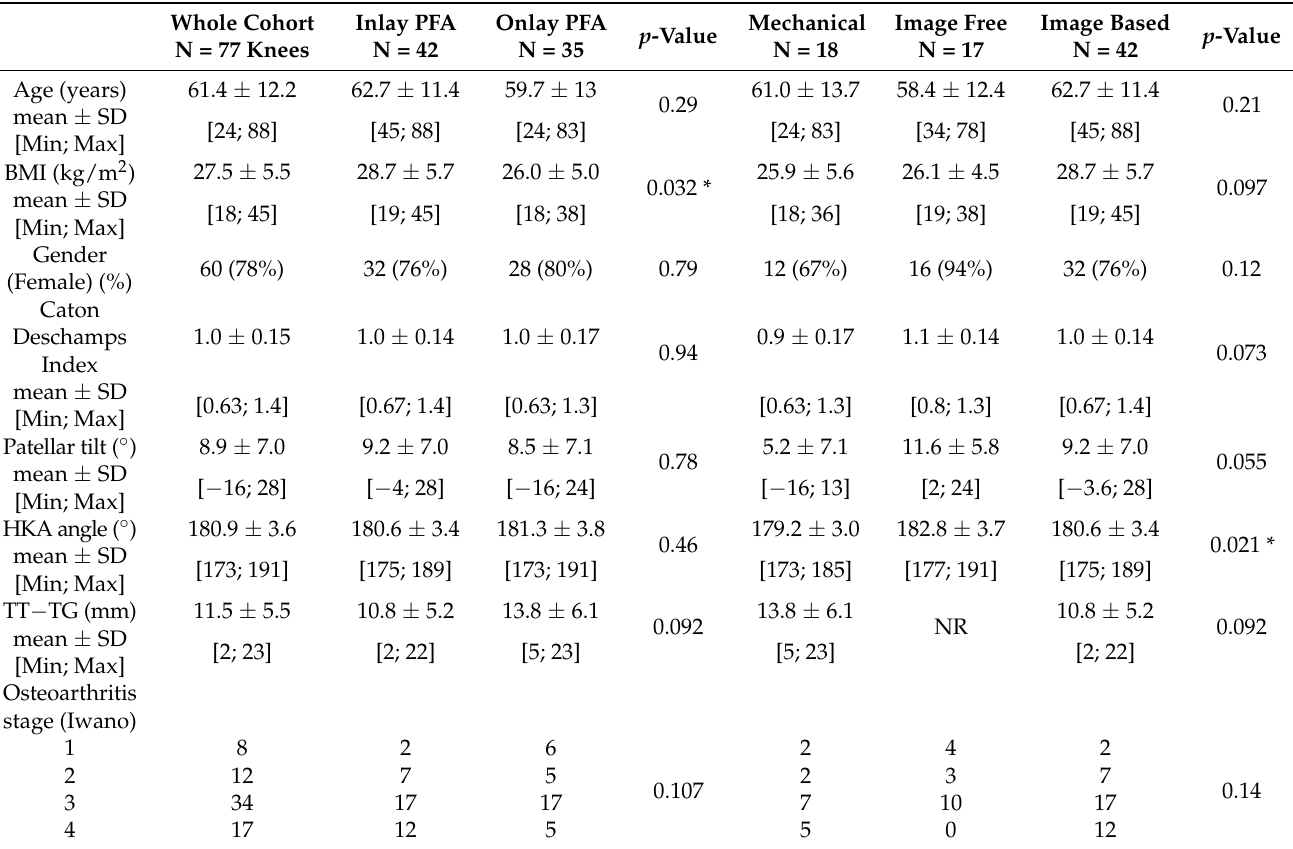
Table 1. Demographic data and preoperative radiological